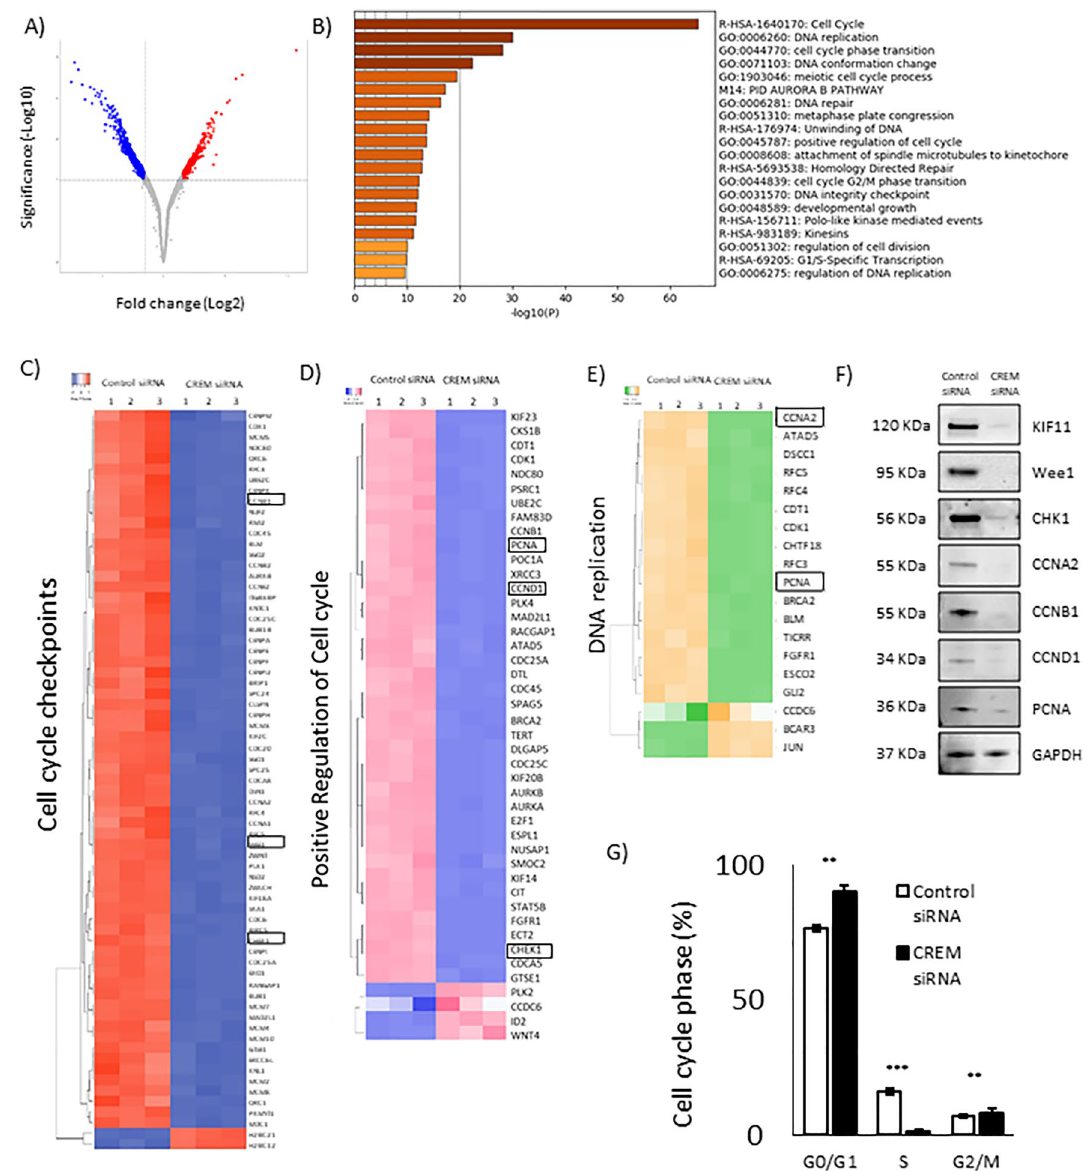
Figure 3. mRNA sequencing of CHL-1 cells treated with control and CREM siRNA. ( A ) Volcano plot for visualization of data selection: red for selected upregulated genes, blue for selected downregulated genes and grey for omitted genes based on significance and fold change. ( B ) Top 20 gene clusters enriched by CREM knockdown. Heatmaps of differentially expressed genes ≥ twofold change upon CREM Knockdown via CREM siRNA, with most being downregulated (upper rows) and small portion of upregulated genes (bottom rows) for ( C ) Cell cycle check points, ( D ) Positive Regulation of Cell cycle and ( E ) DNA replication. ( F ) Cell cycle markers presented in the heatmaps were investigated protein level in western blotting, GAPDH was used as protein loading. The blots are cropped and original blots/replicates can be found in Supplementary information—Original blots Supplementary Figs. S2, S4, S5, S6, S7. ( G ) Cell cycle analysis results presented by cell phases. ** P ≤ 0.01 and *** P ≤ 0.001 ( t